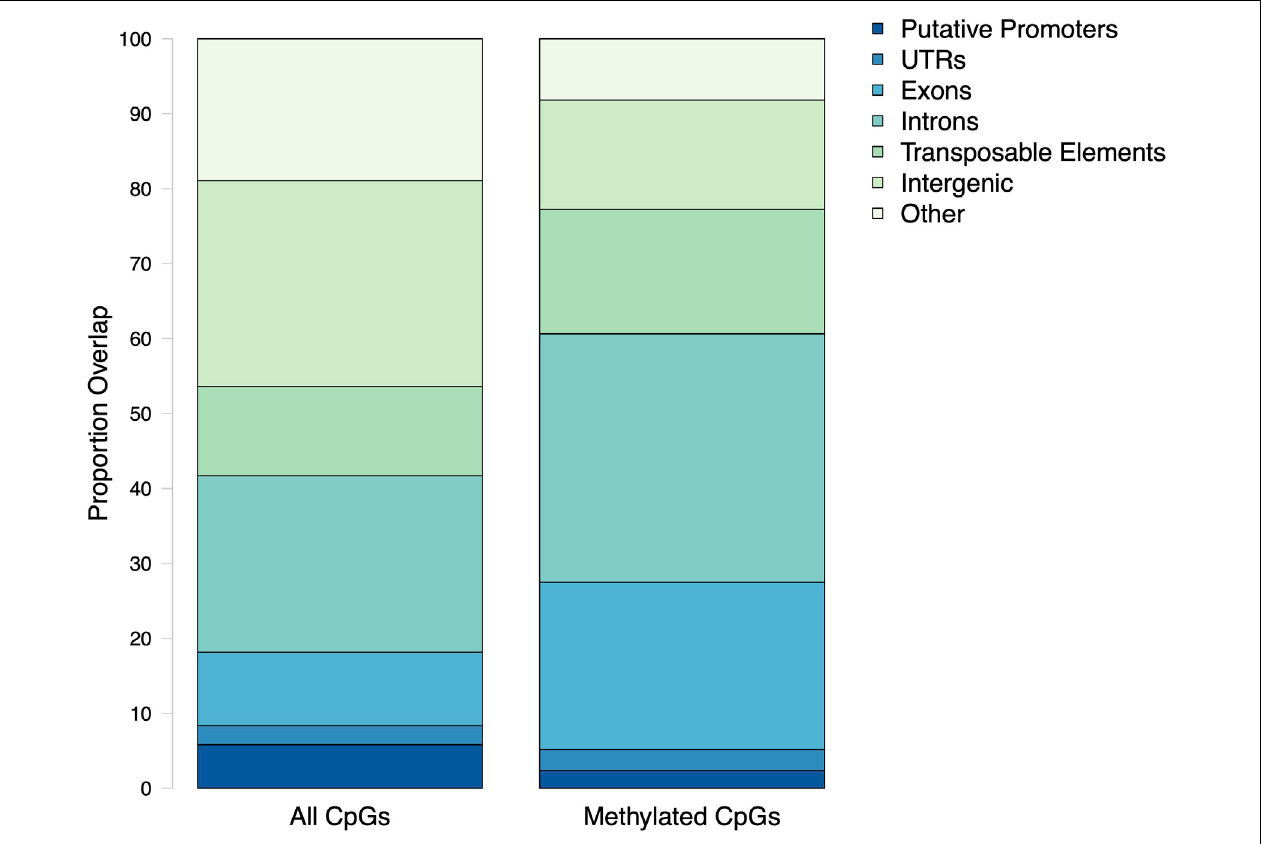
FIGURE 2 | Proportion of CpG loci within genomic features. All CpGs are every dinucleotide in the C. virginica genome. Methylated CpGs refers to a dinucleotide with a methylation level of at least